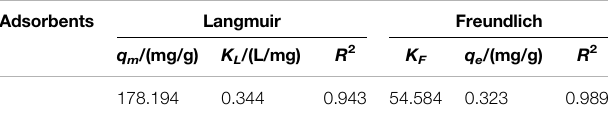
TABLE 4 | Thermodynamic parameters of sludge-based biochar on U(VI)